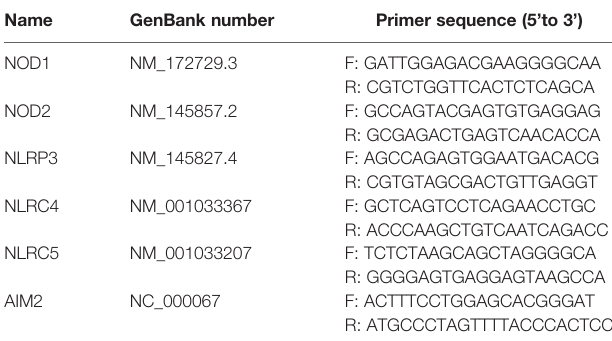
TABLE 2 | qPCR primer sequences of